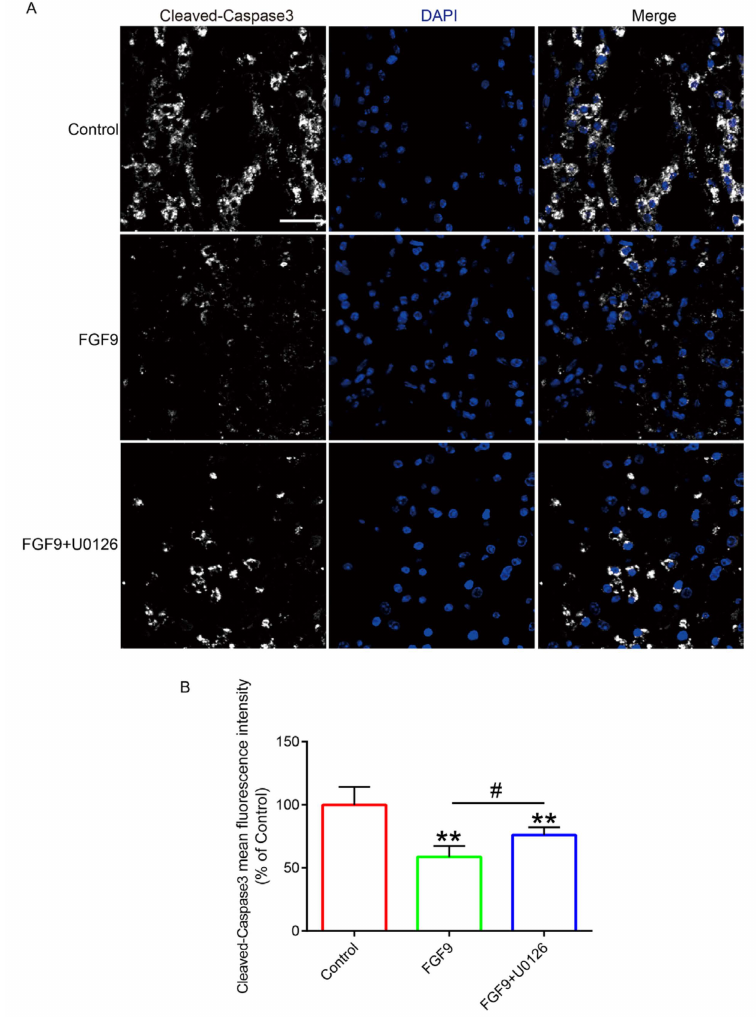
Figure 7. The application of FGF9 effectively reduced the number of cleaved caspase 3-positive cells in tissues. ( A ) Cleaved caspase-3 staining (white) of each group; the nuclei were labeled by DAPI (blue). Magnification = 80 × ; scale bar = 25 µ m. ( B ) Cleaved caspase-3 fluorescence intensity statistics. ** represents p < 0.01 versus the control group; # represents p < 0.05 comparing the FGF9 group to the FGF9+U0126 group, showing statistical significance. Data are the mean values ± SD, n =